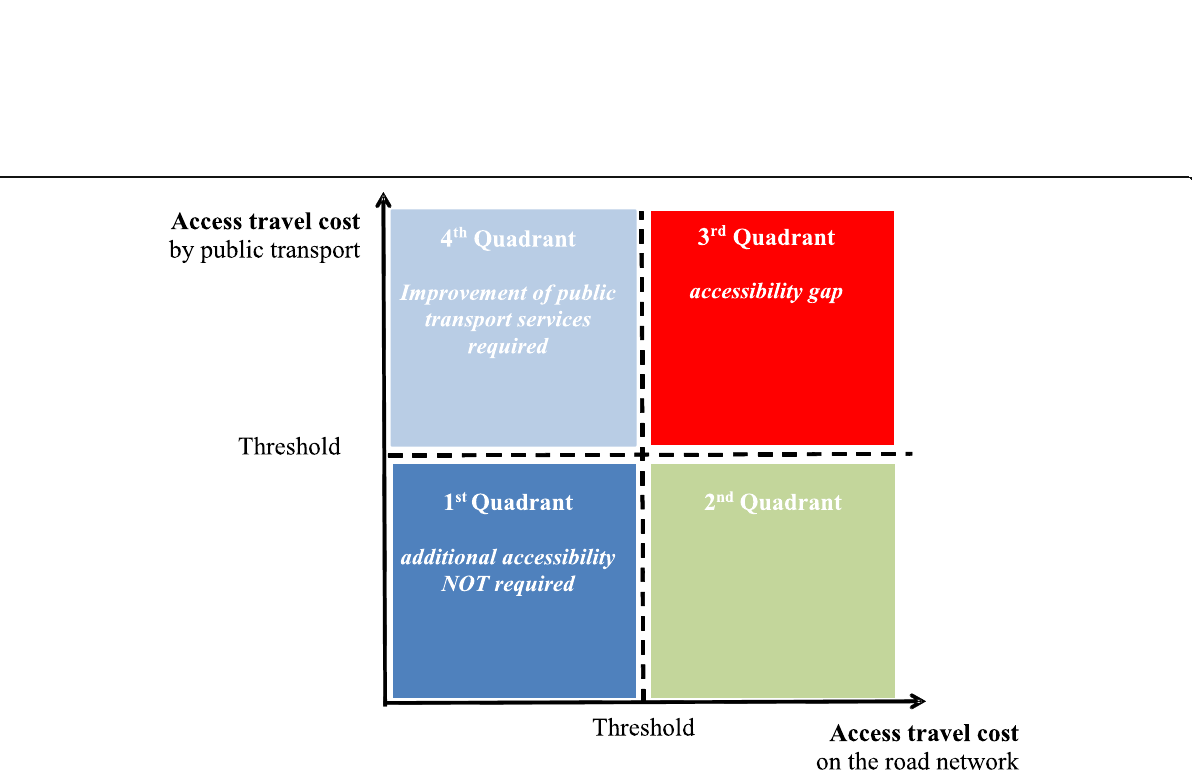
Fig. 6 The Accessibility Gap diagram for differential public vs private transport access travel